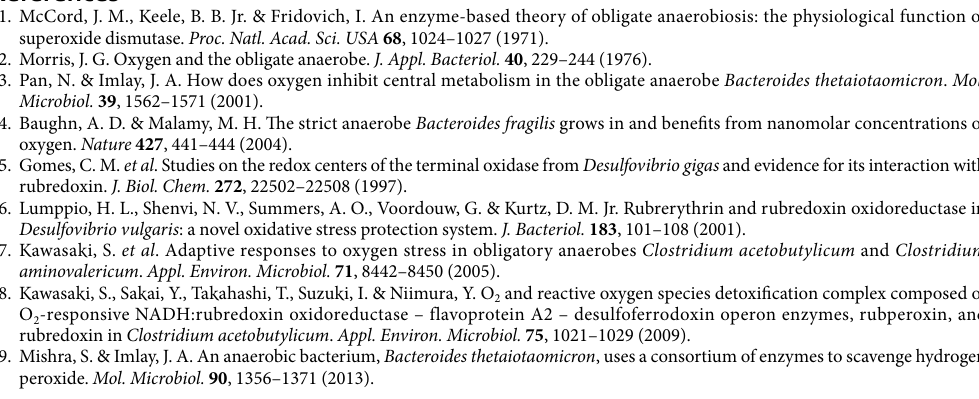
Fig. S1B. The produced DNA fragments were connected to the upstream and downstream regions of the Sp resist- ance gene ( Sp r ) by Golden Gate Assembly 59 with Sap I as the Type IIS restriction enzyme. The obtained fragments cloning site, chloramphenicol (Cm) resistance gene ( Cm r ), and temperature-sensitive replicon origin 60 . B. infantis cells were transformed with pKO403Cm- ∆ npoxA by electroporation 55 . After transformation, the cells were spread and cultured at 42 °C on MRS plates containing Sp (50 µ g/ml). The transformants were transferred onto two MRS agar plates containing either Sp or Cm. The obtained Sp-resistant/Cm-sensitive transformants were selected as candidates for the double-crossover mutant. The deletion of npoxA was confirmed by PCR using Primer-1 and Primer-2 (Fig. S1C) and nucleotide sequencing to confirm the precise